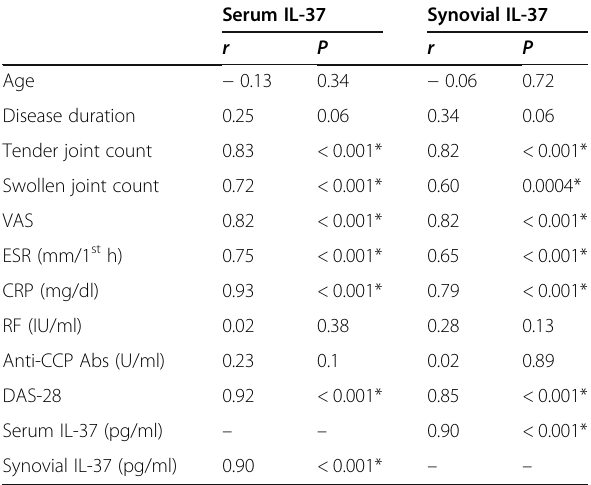
Table 6 Correlations of the serum and synovial IL-37 levels with clinical and laboratory characteristics of the RA patients Serum